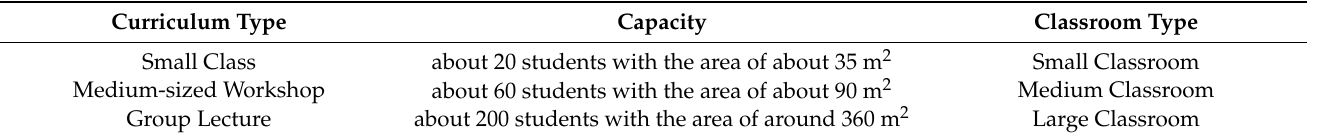
Table 1. Relationship between the curriculum types and the classroom